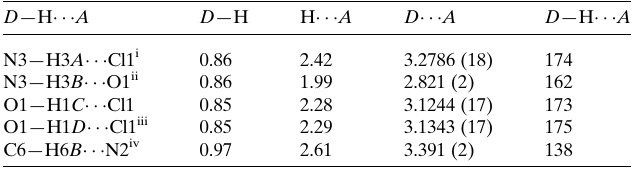
Table 1 Hydrogen-bond geometry (A˚ , (cid:5) ) for the low-temperature structure.